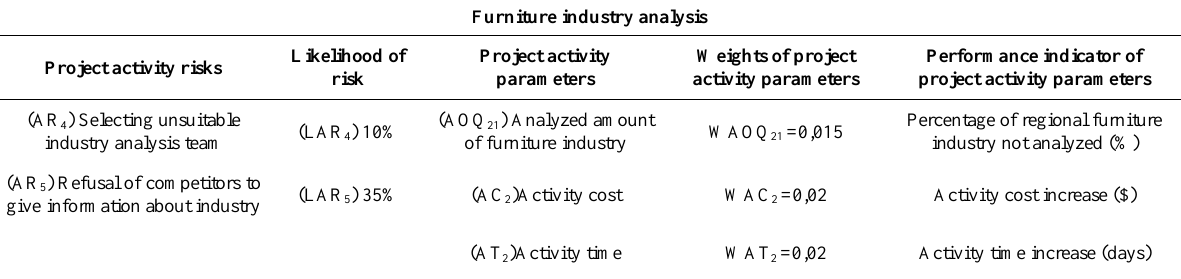
Table 3 . TOPSIS table information of furniture industry